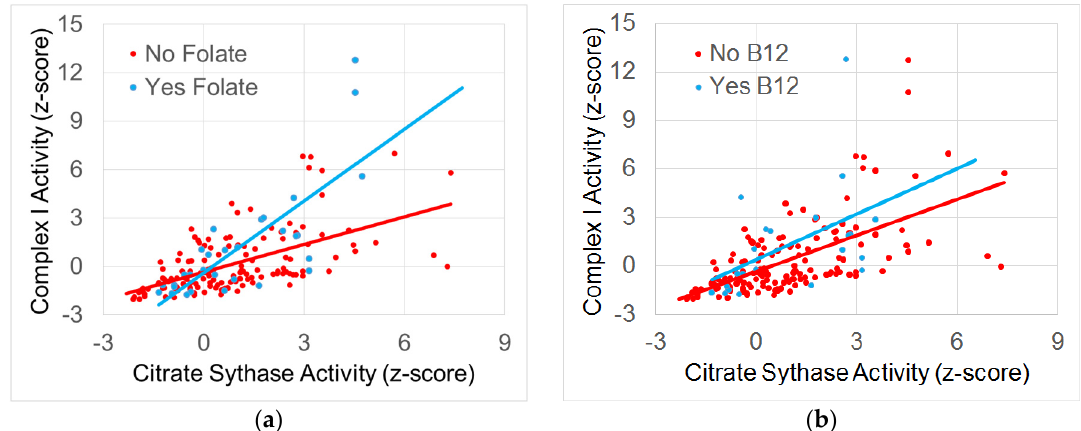
Figure 2. The relationship between normalized Complex I and Citrate Synthase activity. ( a ) Folate and ( b ) B12 supplementation are associated with a significantly greater slope in the relationship between Complex I and Citrate Synthase.